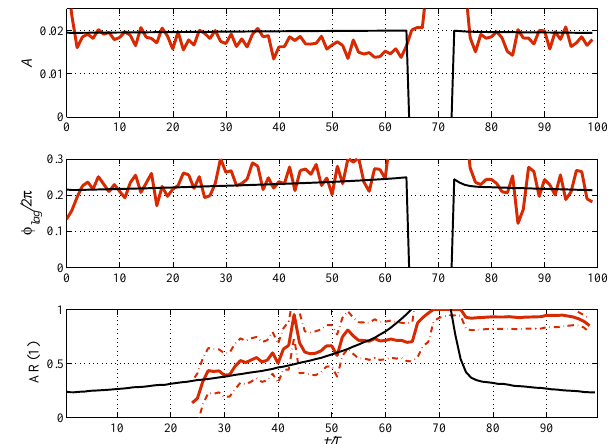
Figure 6. ωτ ∼ 1: The early warning indicators, response amplifi- cation (upper panel), A = D a τ √ , and phase lag (middle panel), 1 + ω 2 τ 2 φ lag = 1 arctan( ωτ ) calculated for the blue time series in Fig. 5. 2 π 2 π In the lower panel, lag 1 autocorrelation of a sliding window of 25 points of the return map is plotted with standard errors (dashed lines) on the estimate. Black lines are theoretical curves of all the quantities. The key point is that phase lag and amplitude response are useful quantities in this regime however the return map is not.